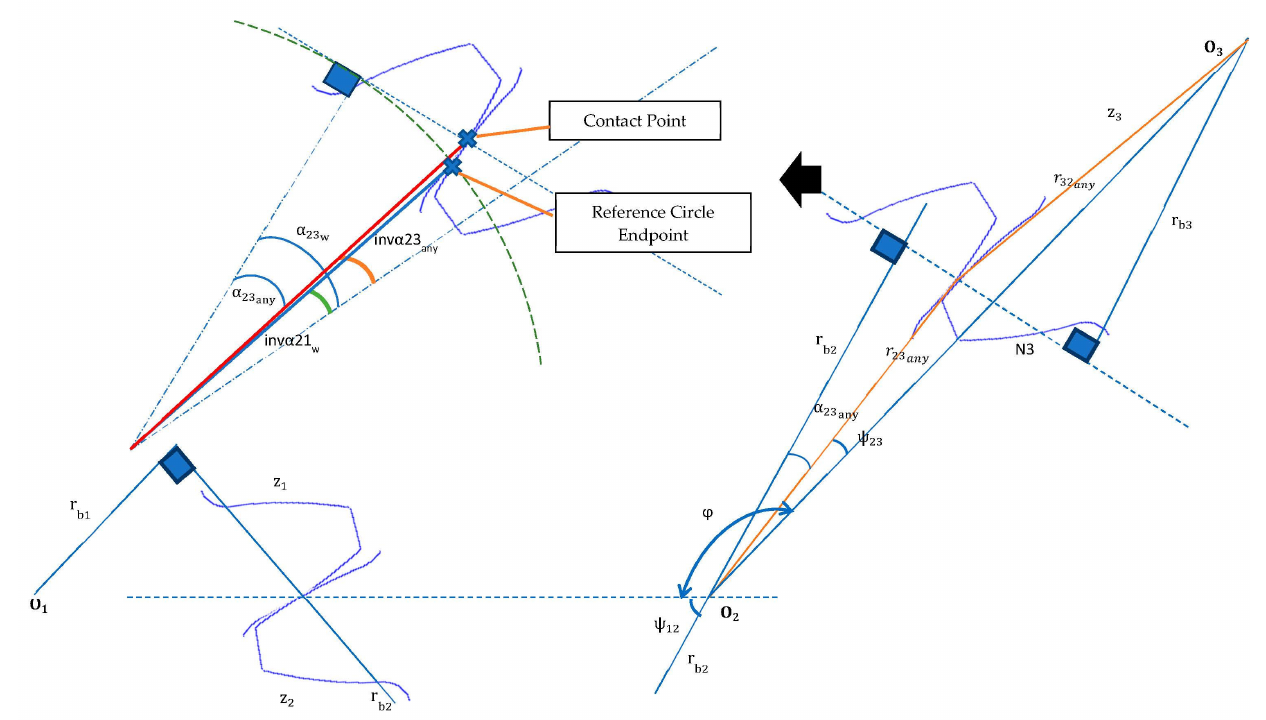
Figure 6. Contact status before centerline.